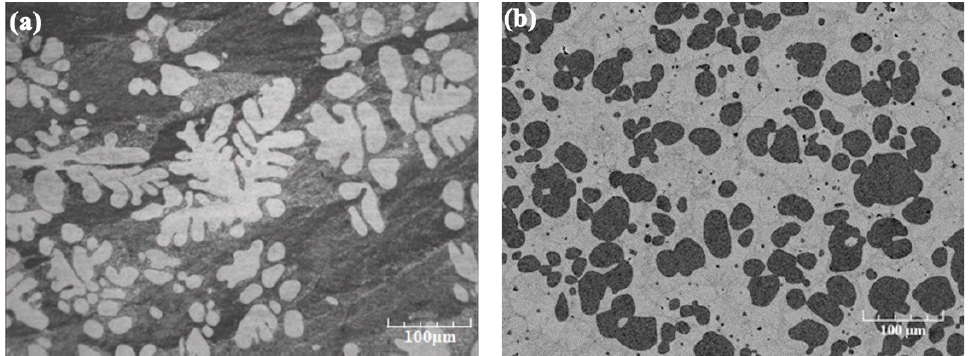
Figure 1. Typical microstructure of ( a ) dendritic morphology formed under conventional solidifica- tion, ( b ) non-dendritic solid particles formed under intensively forced convection for SSM pro- cessing.